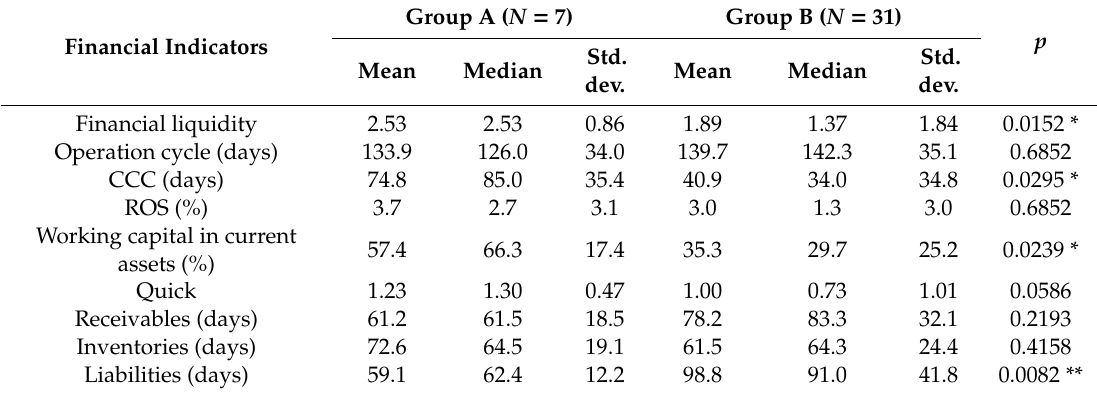
Table 8. Descriptive statistics for financial indicators in both groups with results of Mann–Whitney test.